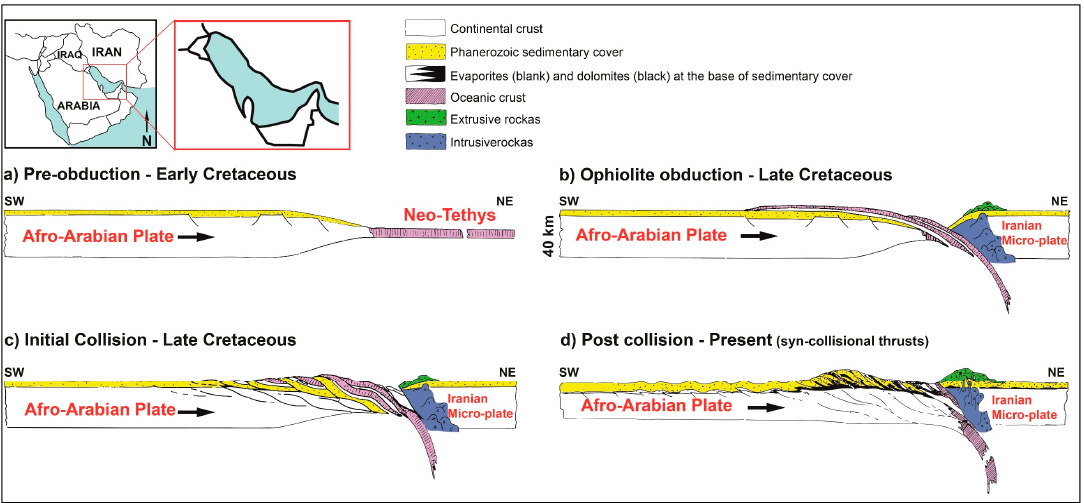
Figure 4. Schematic cross sections illustrating pre-obductional and obductional-initial collisional steps in the evolution of the Zagros collision zone, modified from Reference